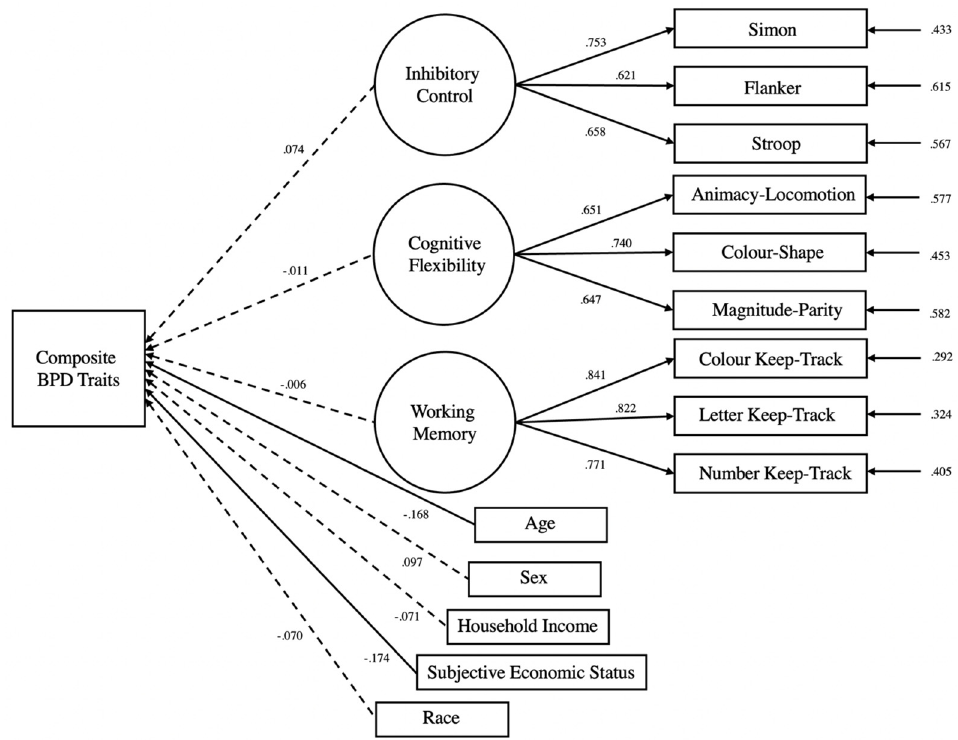
Single-headed arrows connecting latent variables to manifest variables represent standardised factor loadings. Single-headed arrows connecting executive function latent variables to the composite BPD traits represent regressions. Single-headed arrows on the right of the figure represent error terms. The intercorrelations between the executive functions were modelled but not displayed in the figure. Solid lines represent significant relationships, while dashed line represents non-significant relationships, at the 0.05 level.